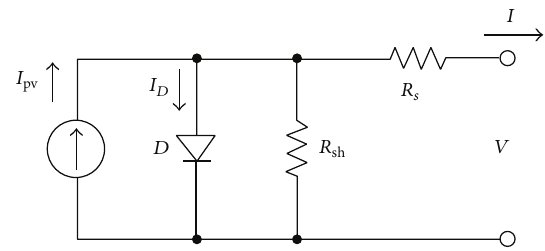
Figure 3: Typical 1-diode equivalent circuit of a solar